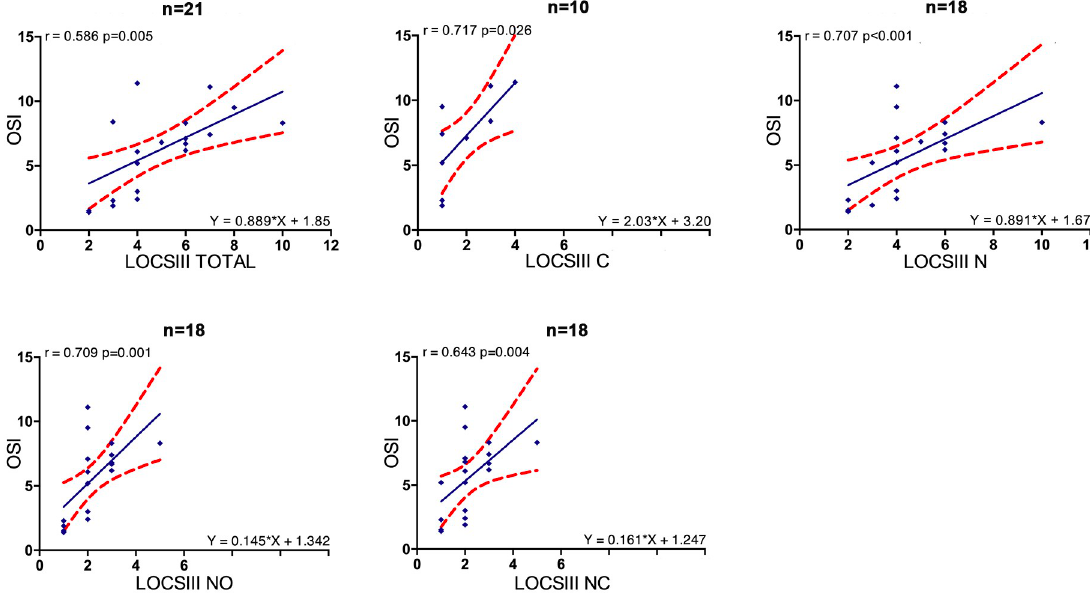
Fig 2. Linear regressions between OSI and LOCS III. Red dots show the 95% CI of the slope and intercept. OSI = objective scatter index, LOCS III = lens opacity classification system III, N = nuclear component = (NO+NC), NO = nuclear opalescence, NC = nuclear color, C = cortical